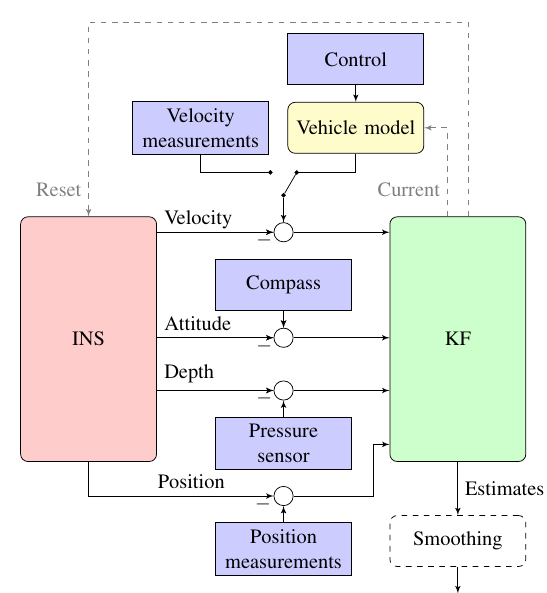
Figure 3: Block diagram of model-aided (and tradi- tional) INS. Additional velocity measure- ments are not included in this paper when utilizing the output from the vehicle model, and the other way around when using veloc- ity measurements. This is illustrated with a switch/selector. The position measurements may be available often or only